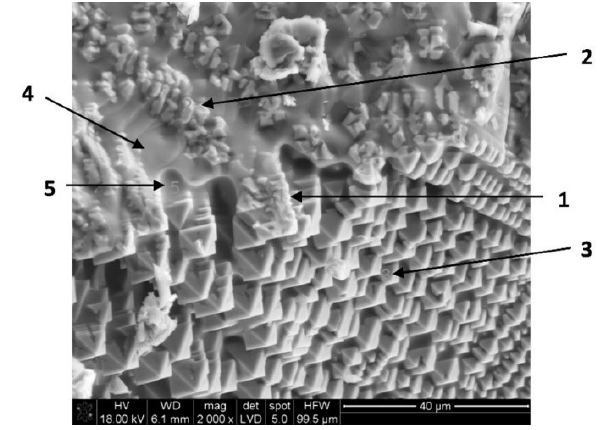
Figure 5. SEM-EDX sample identified as CuCon2.